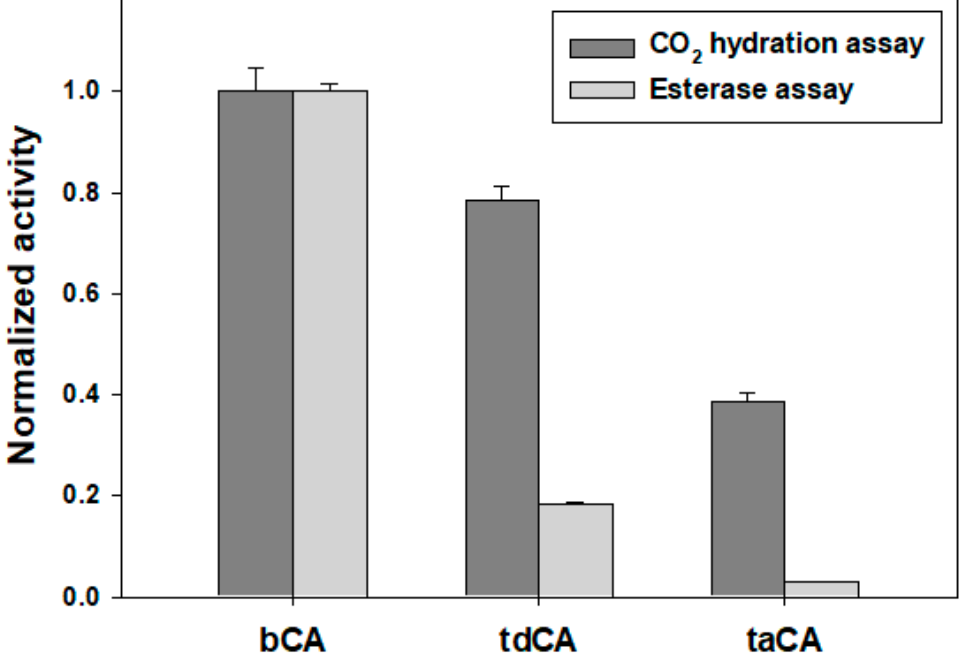
Figure 4. Activities of α -CAs measured by two different assays. The measured activities were normalized to the activity of bCA in each assay. Error bars represent standard deviations from two independent experiments.